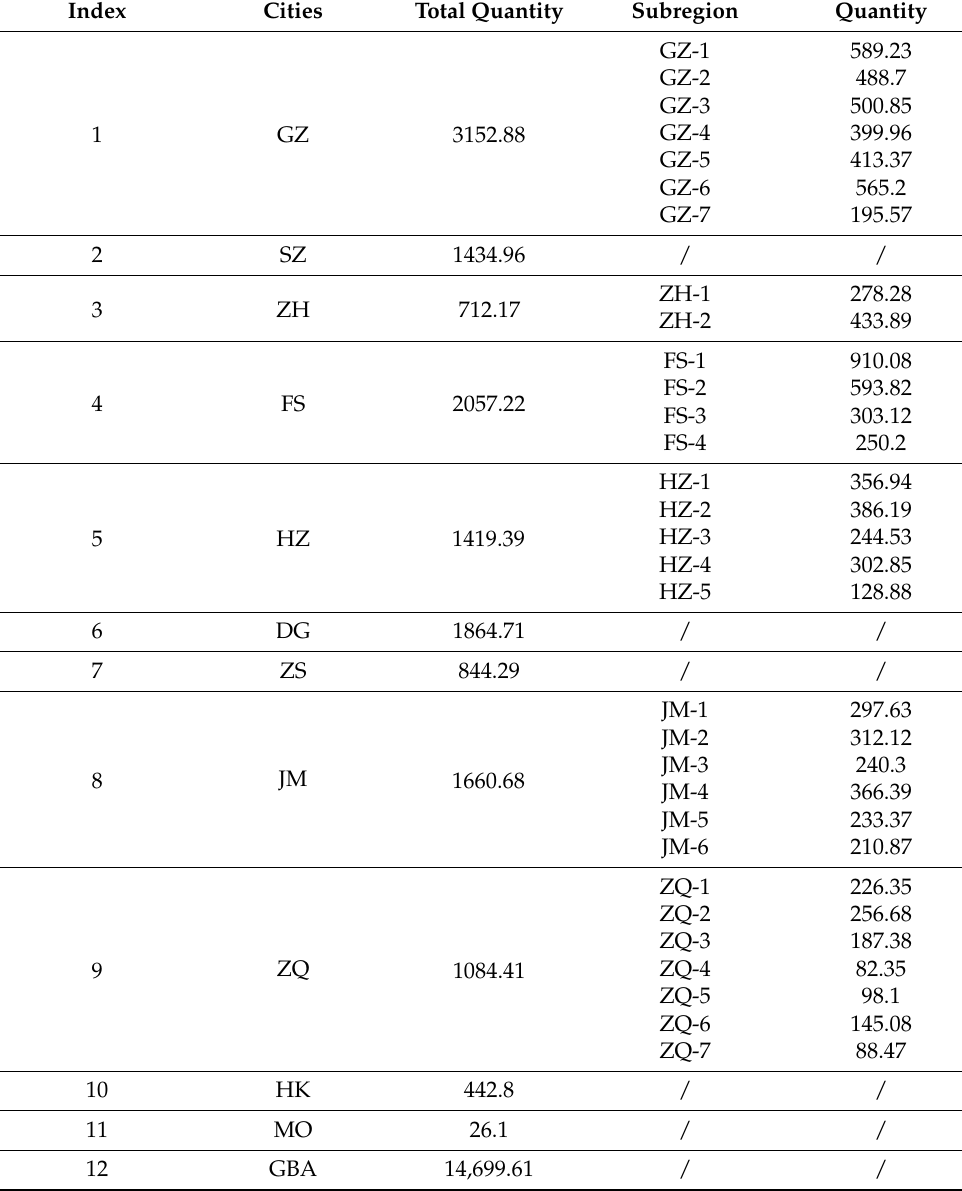
Table 1. Quantity of built-up land in 2050 within the GBA (km 2